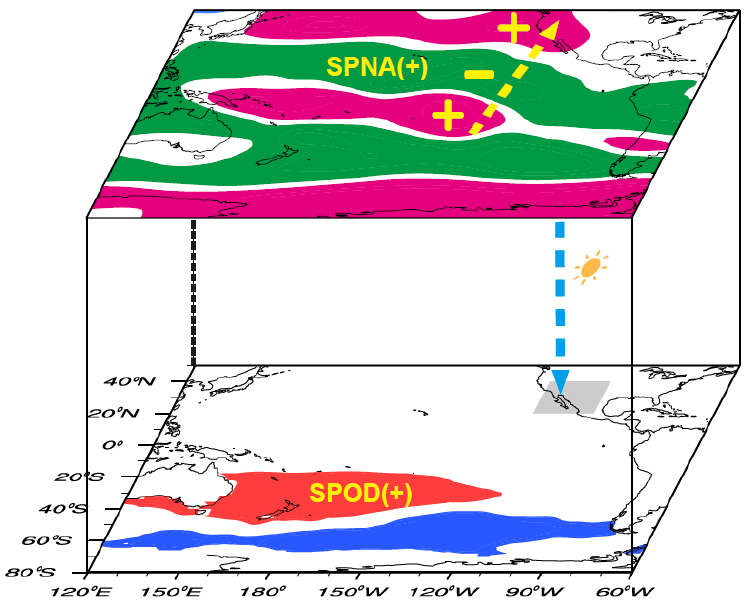
Figure 11. Schematic diagram summarizing the influence of the autumn positive SPOD on winter precipitation in the NAM region. The red and blue shading indicates the SPOD, and the green and magenta shading indicates the SPNA exerted by the winter SPOD. The dotted blue arrow indicates the winter anomalous downward flows associated with the Rossby wave train. The gray box indicates the NAM region.